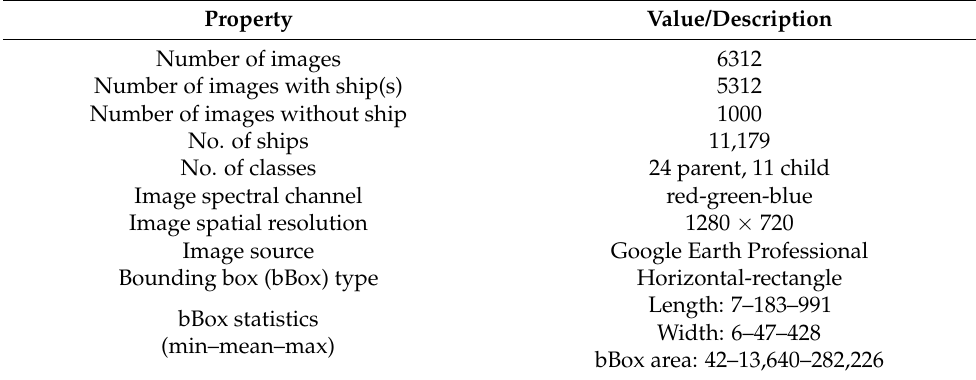
Table 2. VHRShips dataset